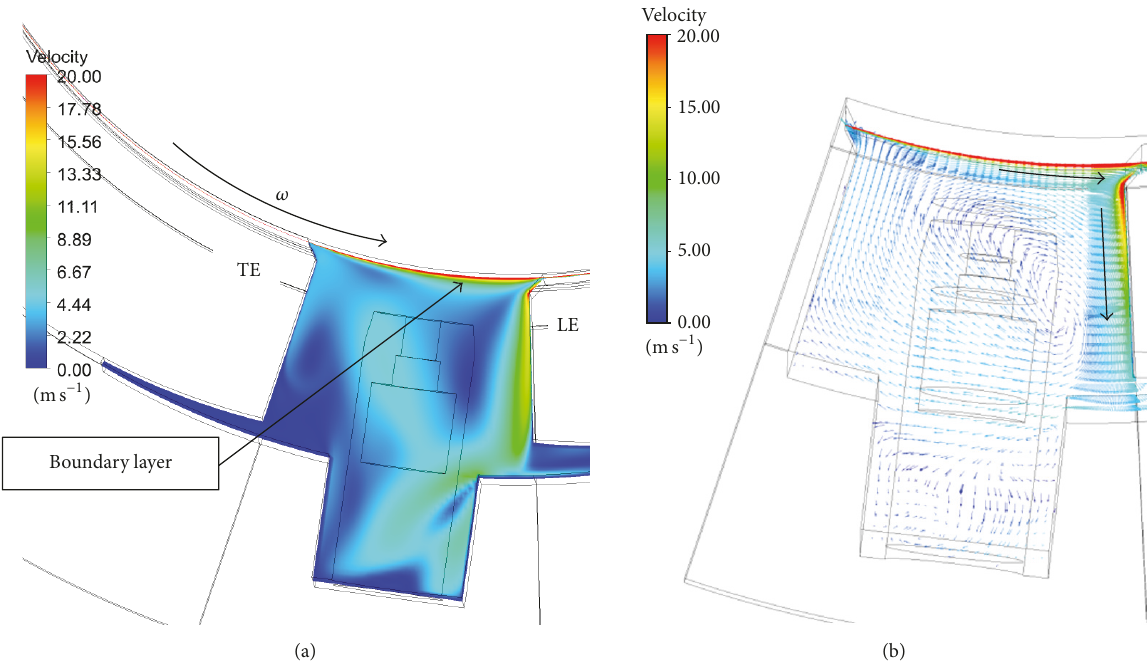
Figure 7: Absolute fluid velocities in the inlet region between pads 2 and 3 (TPB120, 𝑛 = 12000 min −1 , 𝑝 𝑞 = 2 , 0 MPa, 𝑄 = 90 l/min, 𝑇 sup = 50 ∘ C, and 𝑧 = 30